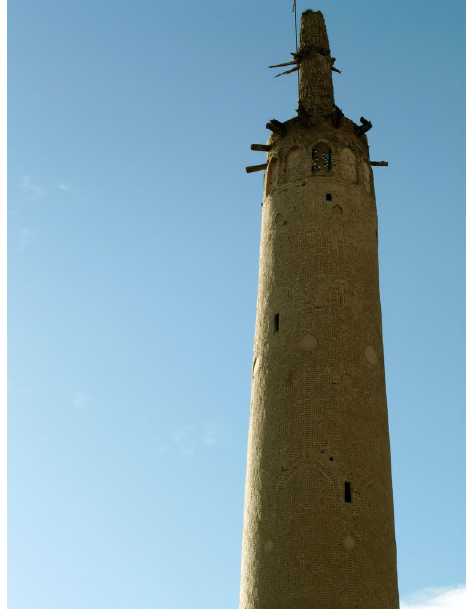
Figure 11: The Golpayegan